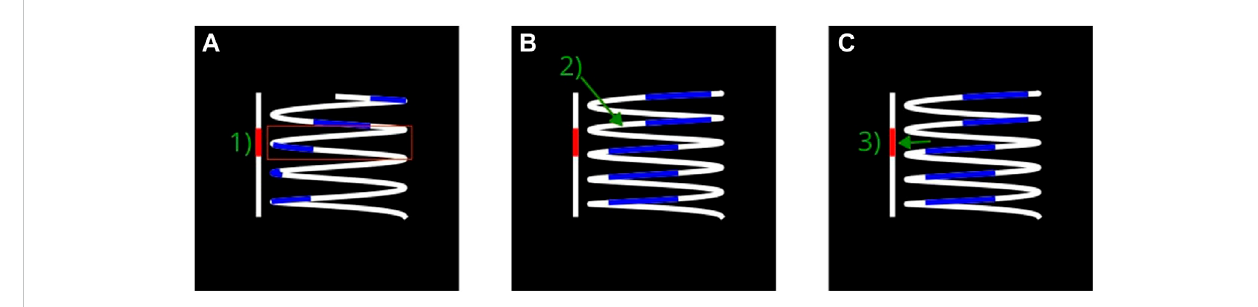
FIGURE 4 The helix allows space to represent alerts on an adjacent representation. Thus, the representation of the abnormal area does not interfere with the representation ofthesensor data.This makes it easierto supporttheworkofoperatorswhocan: (A) Detection ofthezonesuspicious activities, (B) focus on the helix to make a break appears in a periodic pattern (C) . Control if the break corresponds to the alarm.